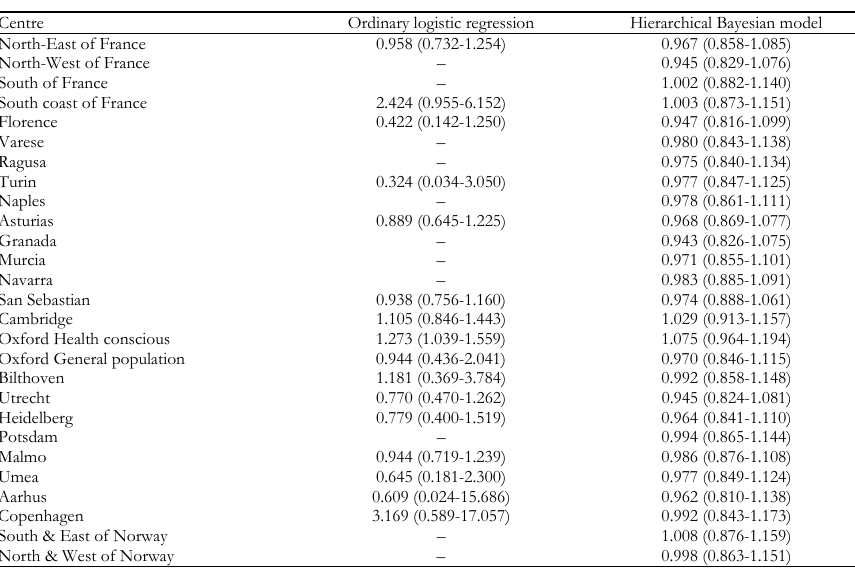
Estimated ORs (95% CI) by centre: legumes